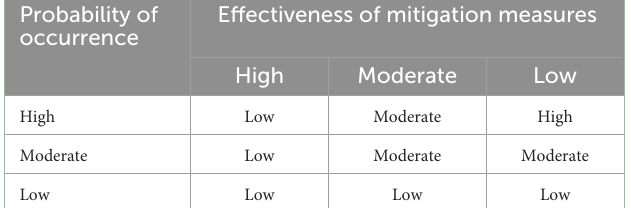
TABLE 6 Risk estimation matrix.